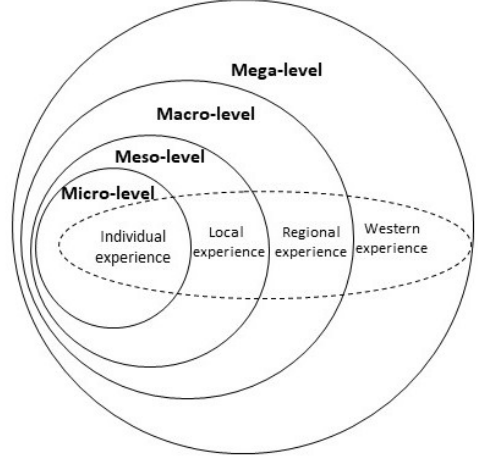
Figure 2. The four nested levels: Micro, Meso, Macro, and Mega.